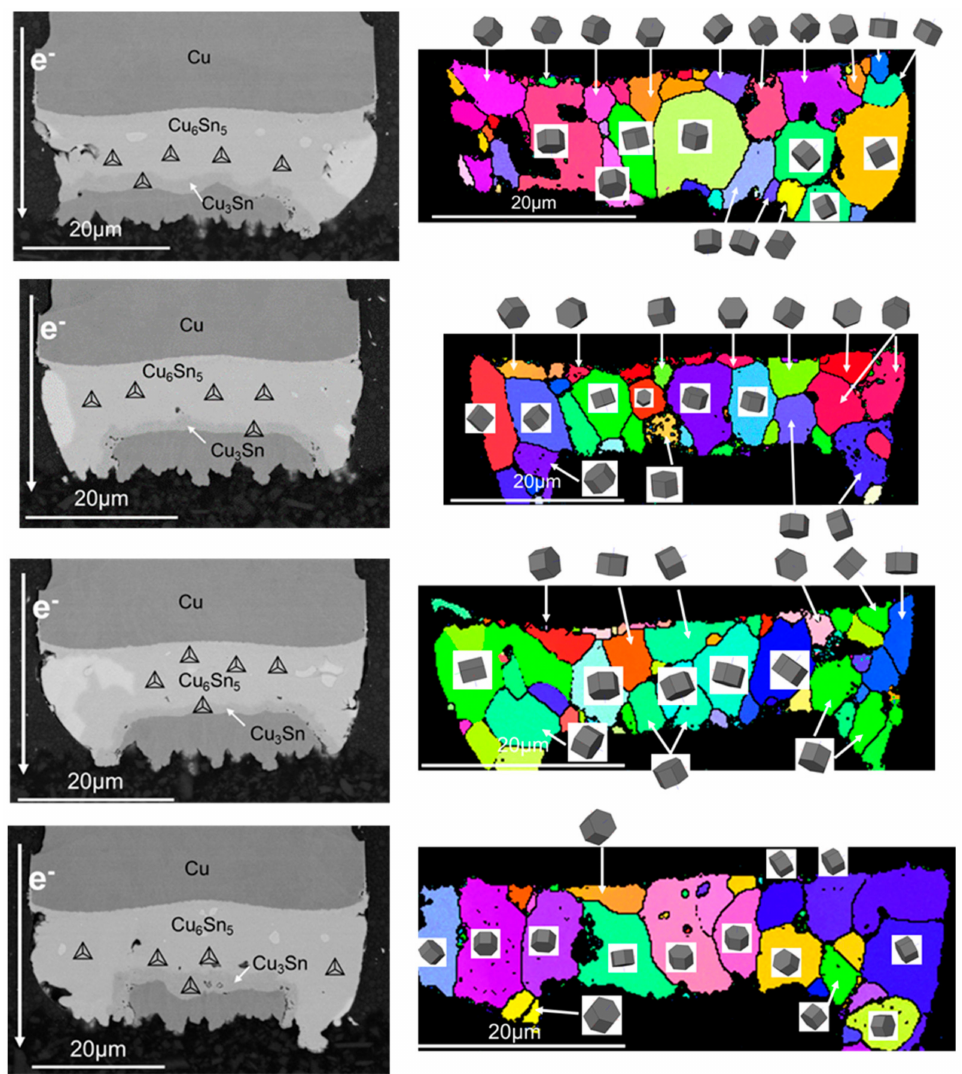
Figure 8. Microstructure after current stressing at 1.5 × 10 4 A/cm 2 at 125 ◦ C for 800